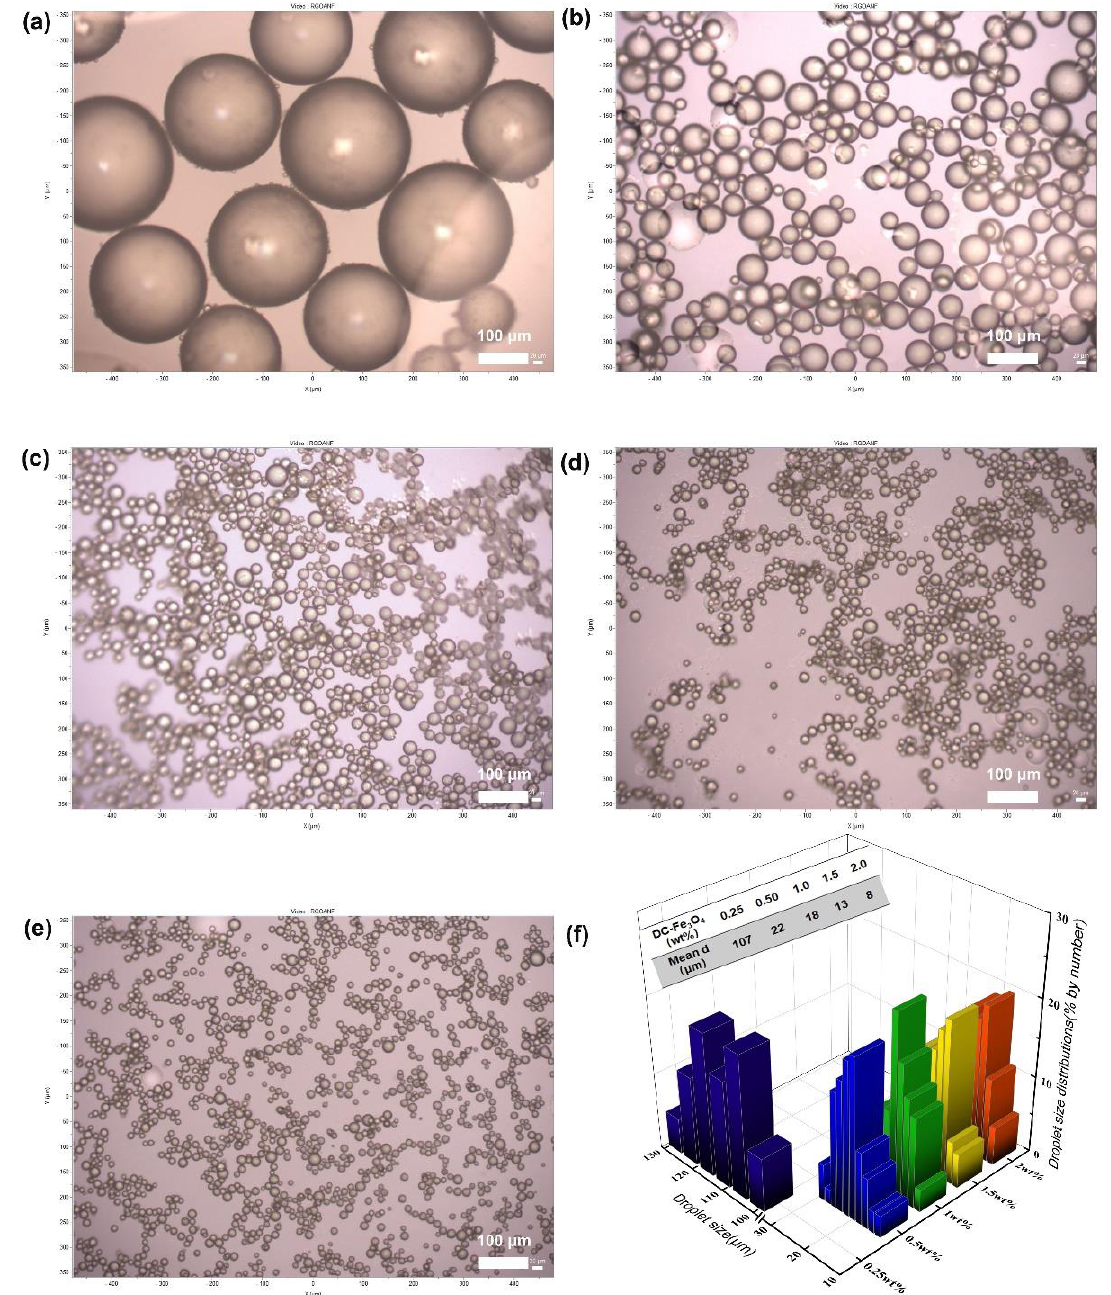
Figure 7. Optical microscopes of the oil-in-water Pickering emulsions stabilized by DC-Fe 3 O 4 nanoparticles at different concentrations with an equal volume of liquid paraffin and water. From ( a ) to ( e ), the DC-Fe 3 O 4 concentration is 0.25, 0.5, 1.0, 1.5, and 2.0 wt%, respectively. The images were taken at 24 h preparation. ( f ) Droplet size distribution of Pickering emulsion stabilized DC-Fe 3 O 4 nanoparticles at different concentrations. The liquid paraffin and water were in an equal volume ratio.